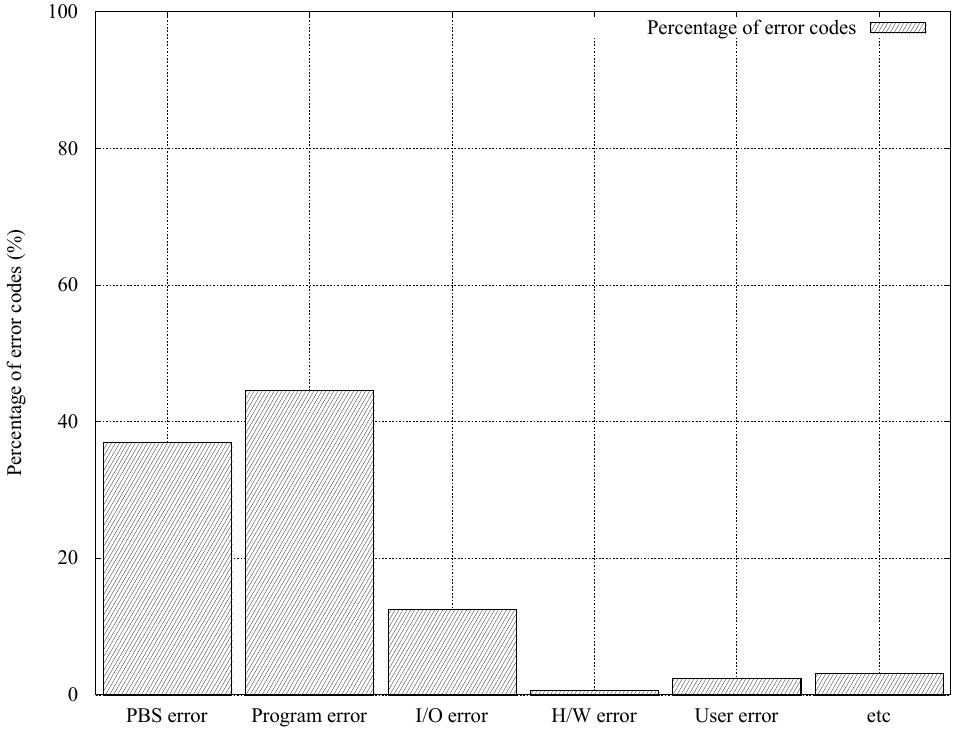
Figure 2. Classification of the cause of failed jobs by error codes.